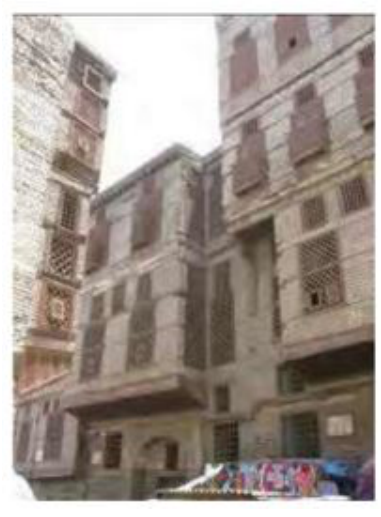
Figure 6. Al-Qanadili